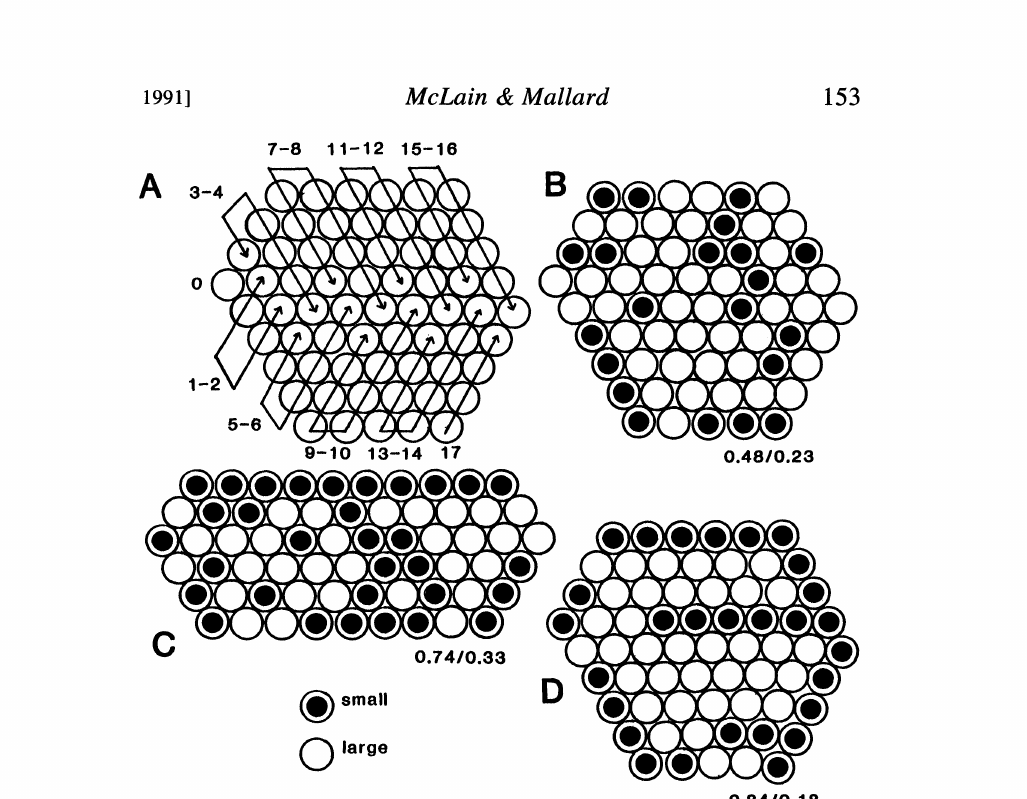
Figure 9. Arrangement of eggs within an egg mass. (A) Pattern of egg deposition giving rise to the typical hexagonal array of eggs. Numbers beside vectors identify the order in which rows were laid while vector length corresponds to the number of eggs laid. Point 0 is the initial egg laid. (B-D) Simulations of the arrangement of large and small eggs if females terminate a row and initiate a new row upon encountering a small egg (see Discussion for constraints on the hypothetical behav- ior pattern). Ratios indicate proportion of small eggs in outer (numerator) and inner (denominator) rows. (B) Small eggs occur at random and at a frequency of 0.33. (C) Small eggs occur at random and at a frequency of 0.50. (D) Small eggs occur regu- larly at a frequency of 0.33; last eggs to mature are